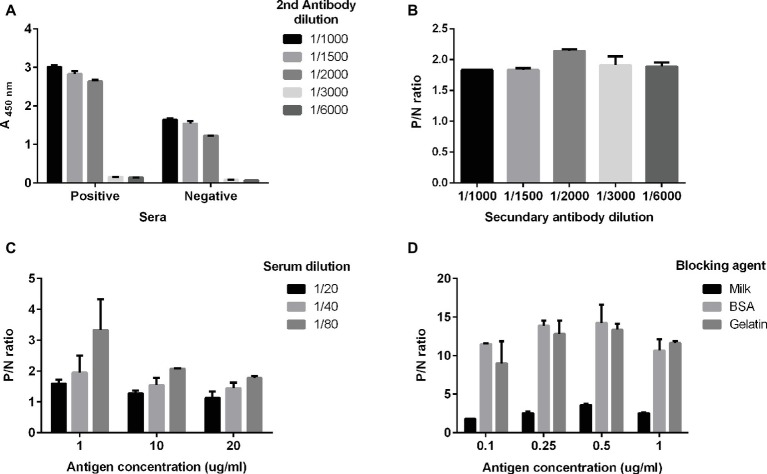
Optimal conditions for the in-house ELISA. Serum samples previously determined as positive or negative for anti-HEV IgG with the commercial kit (DIA.PRO) were used. The optimal dilutions of serum samples (A) and of the secondary antibody were determined (B) using an antigen concentration of 10 μg/ml. Serum samples positive for anti-HEV IgG or negative for anti-HEV IgG, as previously determined with the commercial assay, were used. (C) Optimal antigen concentration at three serum dilutions 1:20 (black balks), 1:40 (light gray balks) and 1:80 (dark gray balks) and (D) different blocking agents. P/N ratio in (B–D) is calculated as the relation A(λ 450 nm) positive sample/A(λ 450 nm) negative control.